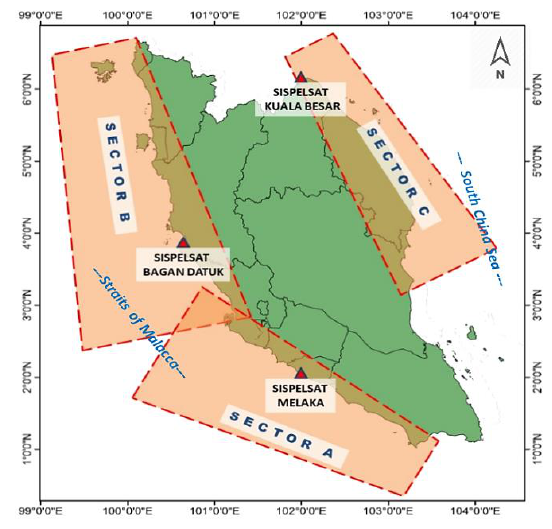
Figure 5. The study area